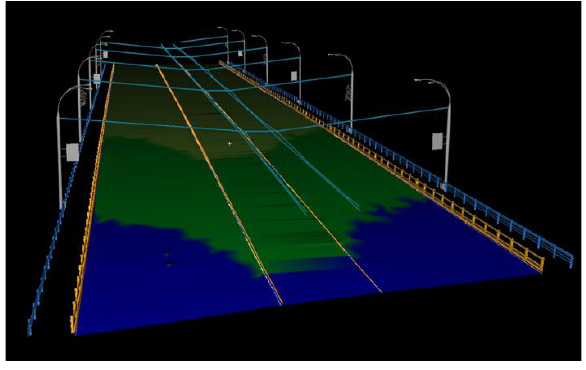
Figure 18 . Road 3D model with